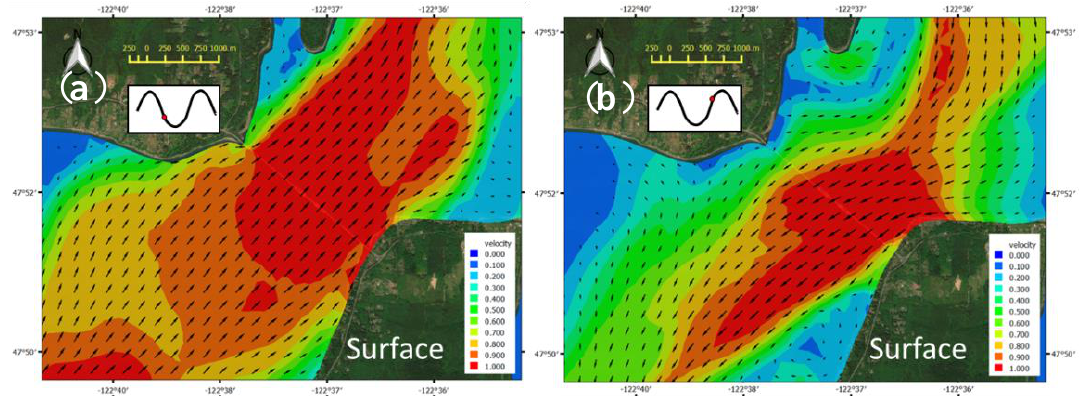
Figure 14. Predicted horizontal velocity contour and vector plots for test 1 scenario without HCB present for ( a ) ebb and ( b ) flood currents in the surface layer. (Typical spring tide on 27 April 2017).